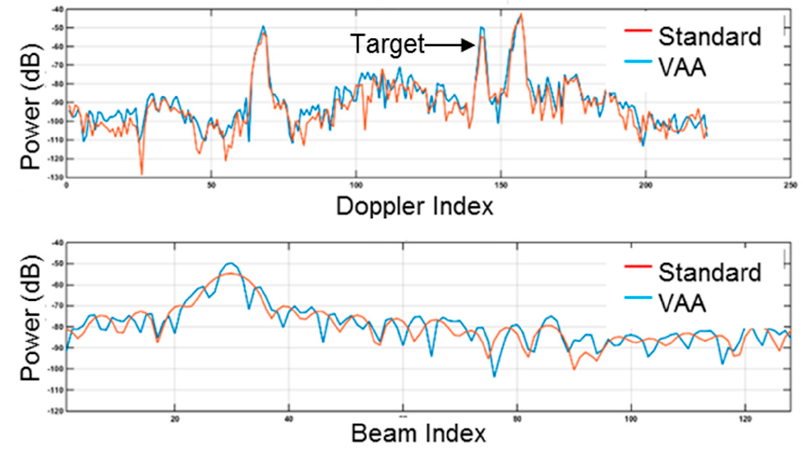
Figure 3. Comparison of the performance of the virtual aperture array technique relative to standard showing an approximately 3 dB improvement in the target-to-clutter ratio and a reduction of the azimuth beam width by 50%.